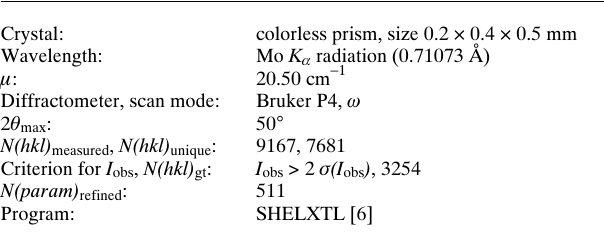
Table 1. Data collection and